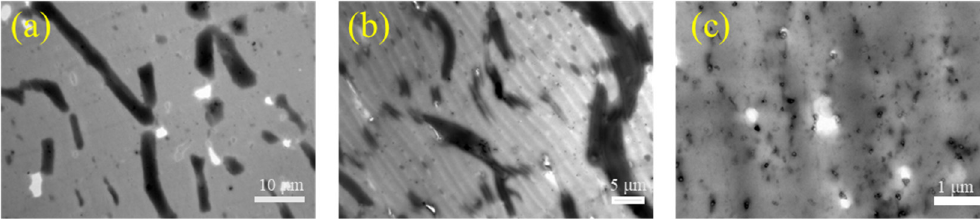
Figure 3. TEM image of ultrathin cross sections of PVPK15: ( a ) using 15% of PVPK15; ( b ) using 25% of PVPK15; and ( c ) using 30% of PVPK15.